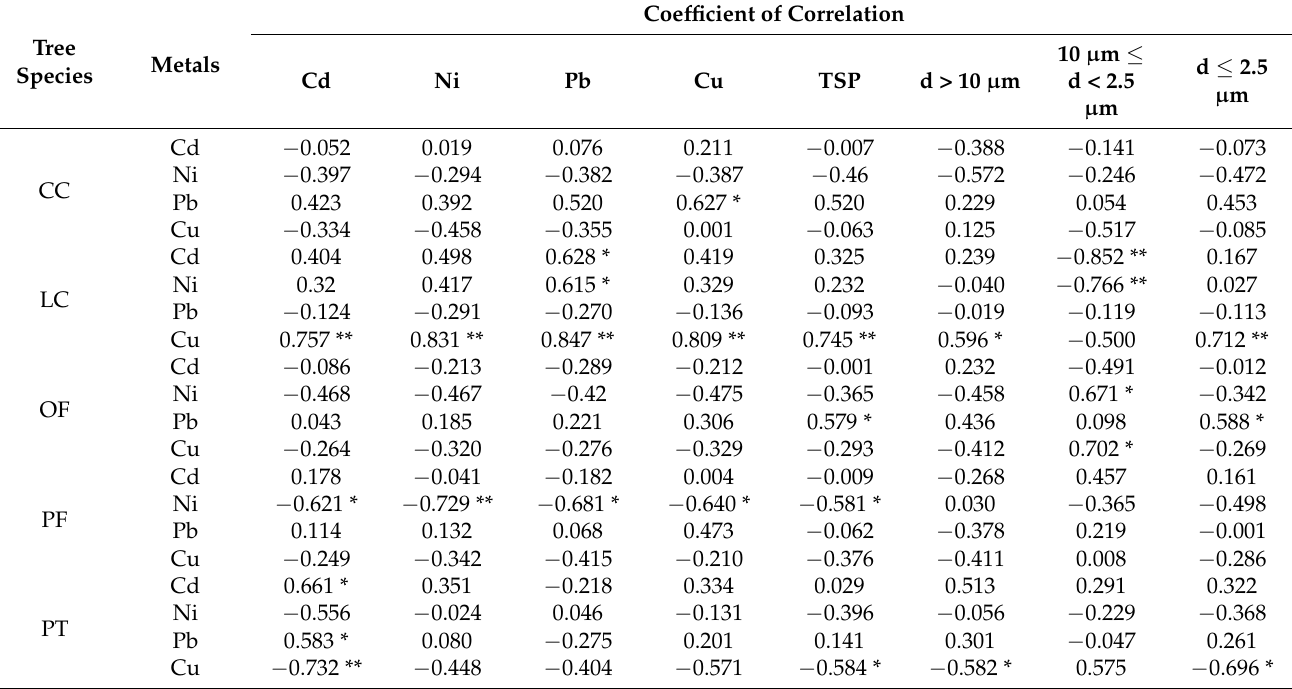
Table 2. Correlations of metal content in leaves and leaf particulate